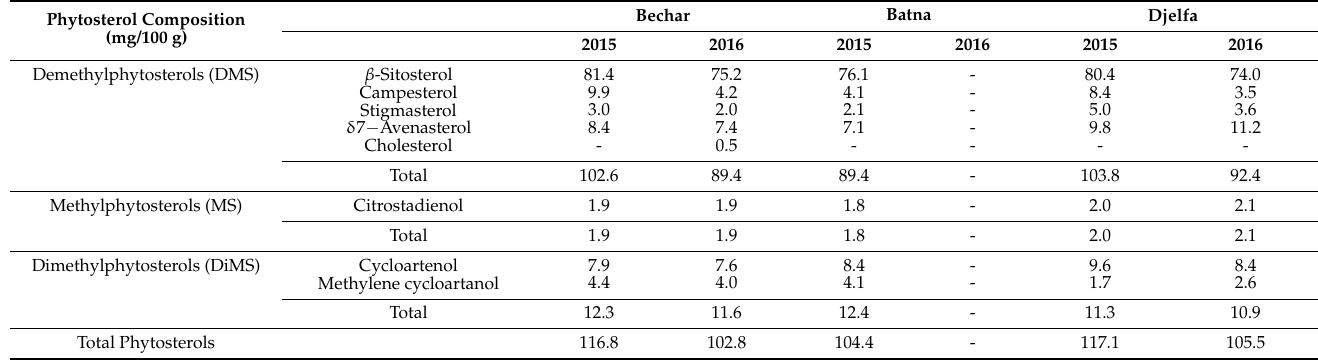
Table 5. Sterol Composition of the Atlas Pistachio Fruit in Different Geographic Zones in Algeria for Two Years (2015 and 2016).